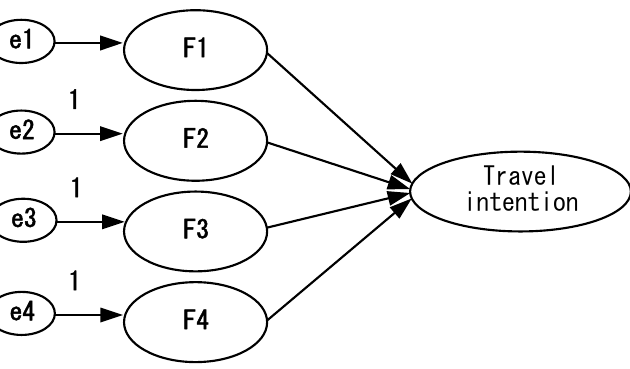
Figure 6. Travel intention model—confirmatory factor analysis framework.